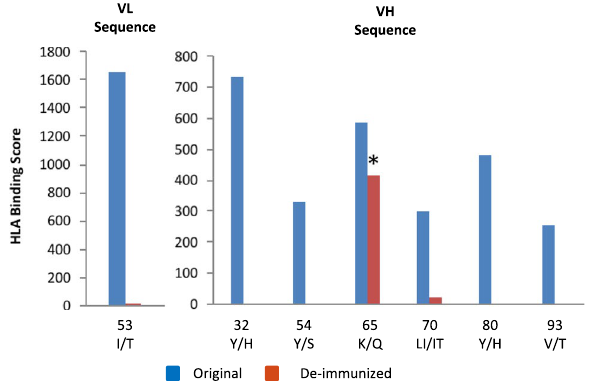
Figure 4. HLA binding scores of critical VL and VH peptides. In silico peptide binding to human MHC II molecules before (blue) and after de-immunization (red). * Indicates a conversion to germline amino